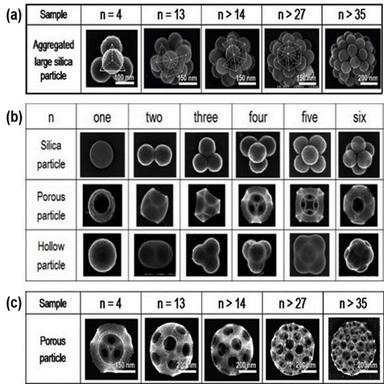
(a) Packing of spherical particles in droplets during drying, (b) Formation of hollow and porous structures of silica nanoparticles using PSL as template particles, and (c) Structures of porous particles with different numbers of template PSL. Reprinted (adapted) with permission from (ACS Nano 2010; 4 (8); 4717–4724). Copyright © 2010, American Chemical Society.